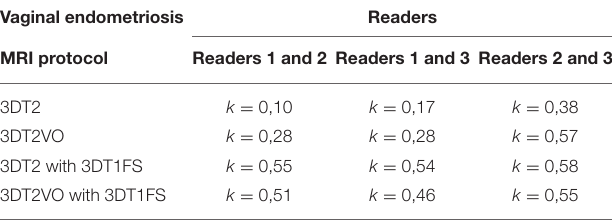
TABLE 5 | Interobserver agreement between readers according to MRI protocol. TABLE 6 | Interobserver agreement between readers according to high-signal- intensity spots detected on